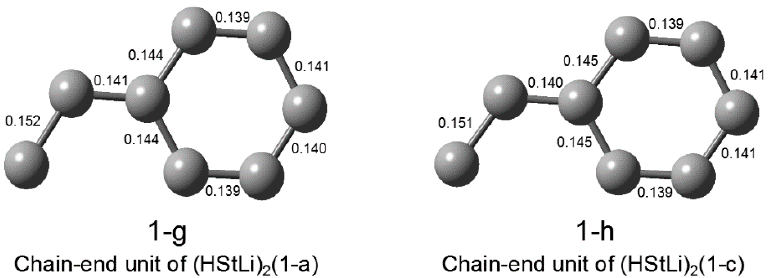
Figure 1-2. C–C bond distances of (HStLi) 2 (1-a) and (1-c). Geometry of the carbon framework of one chain-end unit (HSt-) is shown for (HStLi) 2 (1-a) and (1-c). Distances of C–C bonds are expressed in nm.